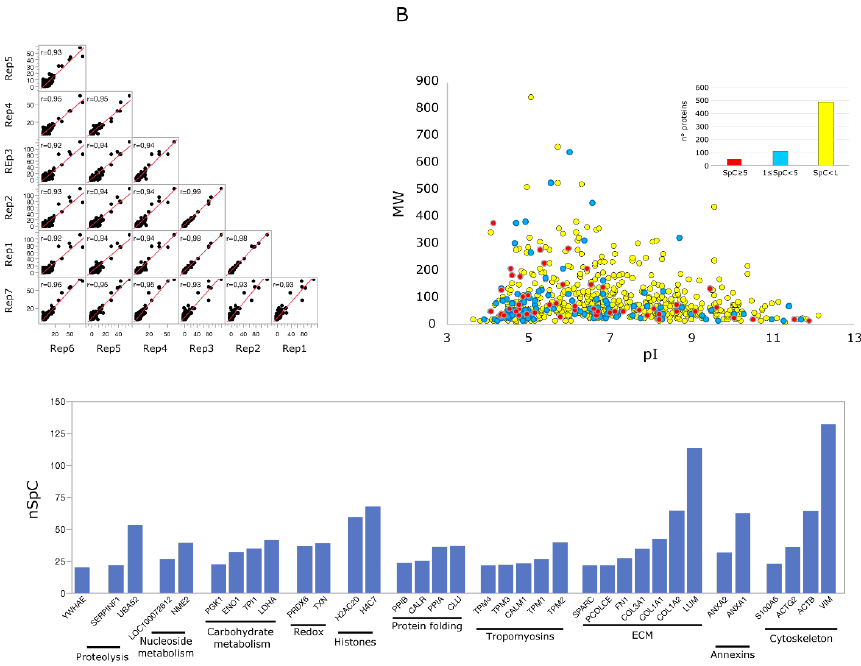
Figure 8. Proteomic analysis secreted from equine mesenchymal stem cells. ( A ) Spearman’s correlation computed using Spectral counts of replicate LC-MS/MS analysis. ( B ) Virtual 2D-Map (pI vs. MW) of the total proteins identified ( n = 647); color codes indicated the average spectral counts characterizing the identified proteins. ( C ) Rank list of the most abundant identified proteins ( n = 35, nSpC > 20) clustered for functional